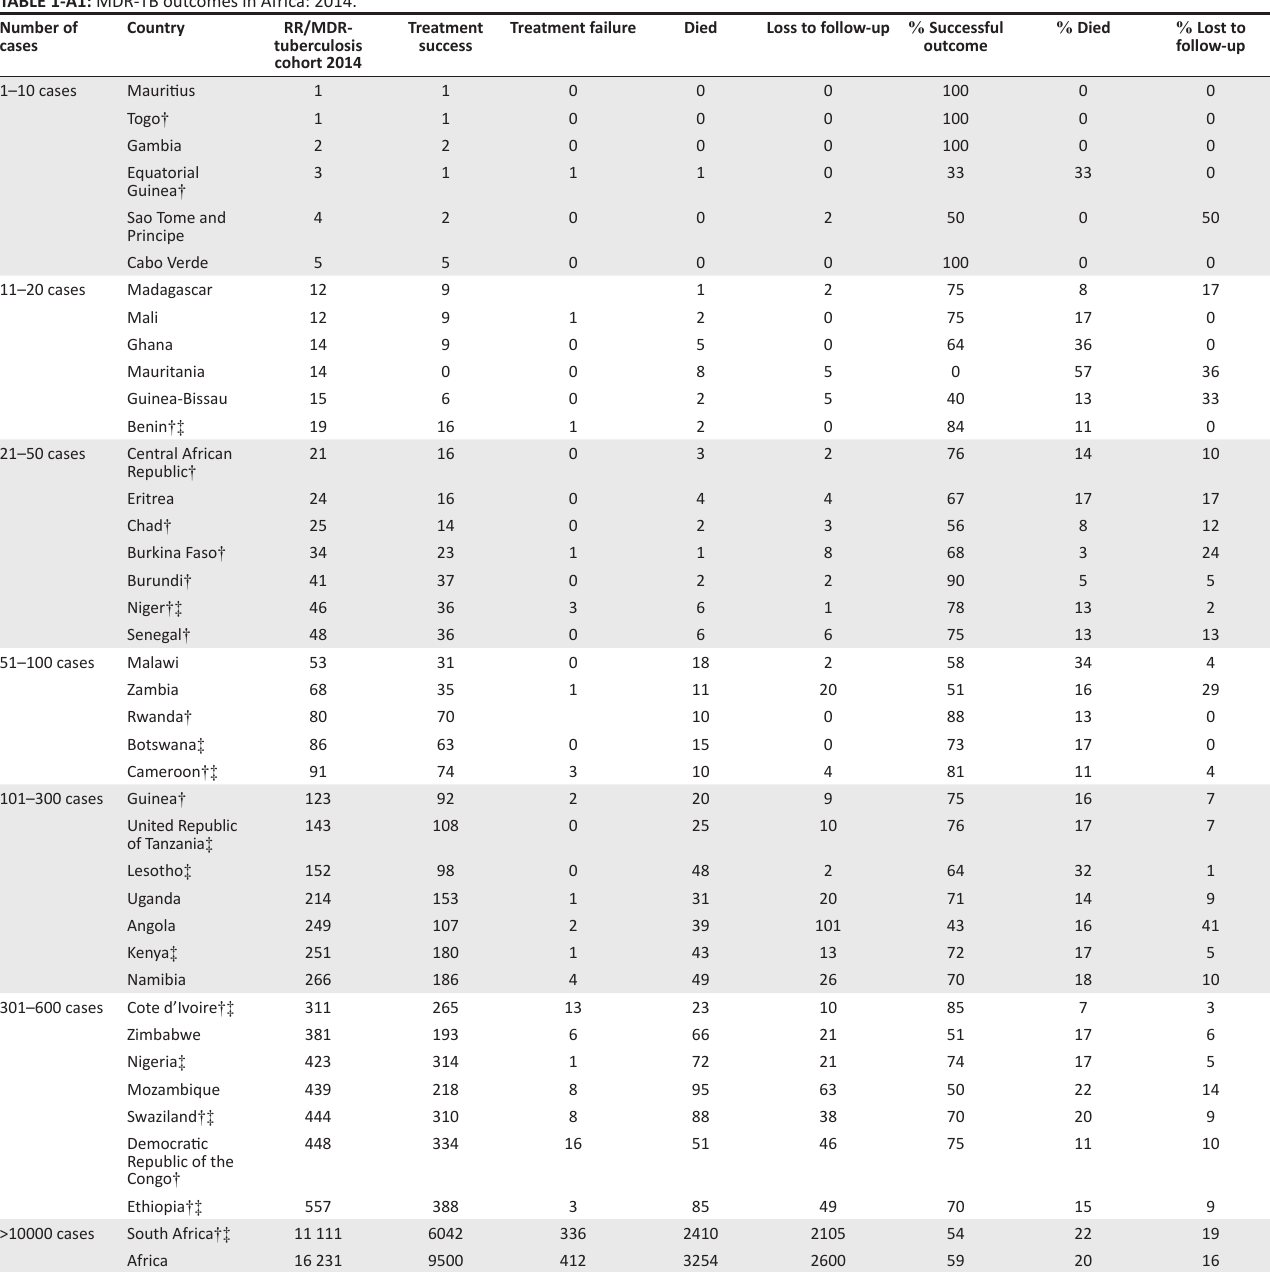
TABLE 1-A1: MDR-TB outcomes in Africa: